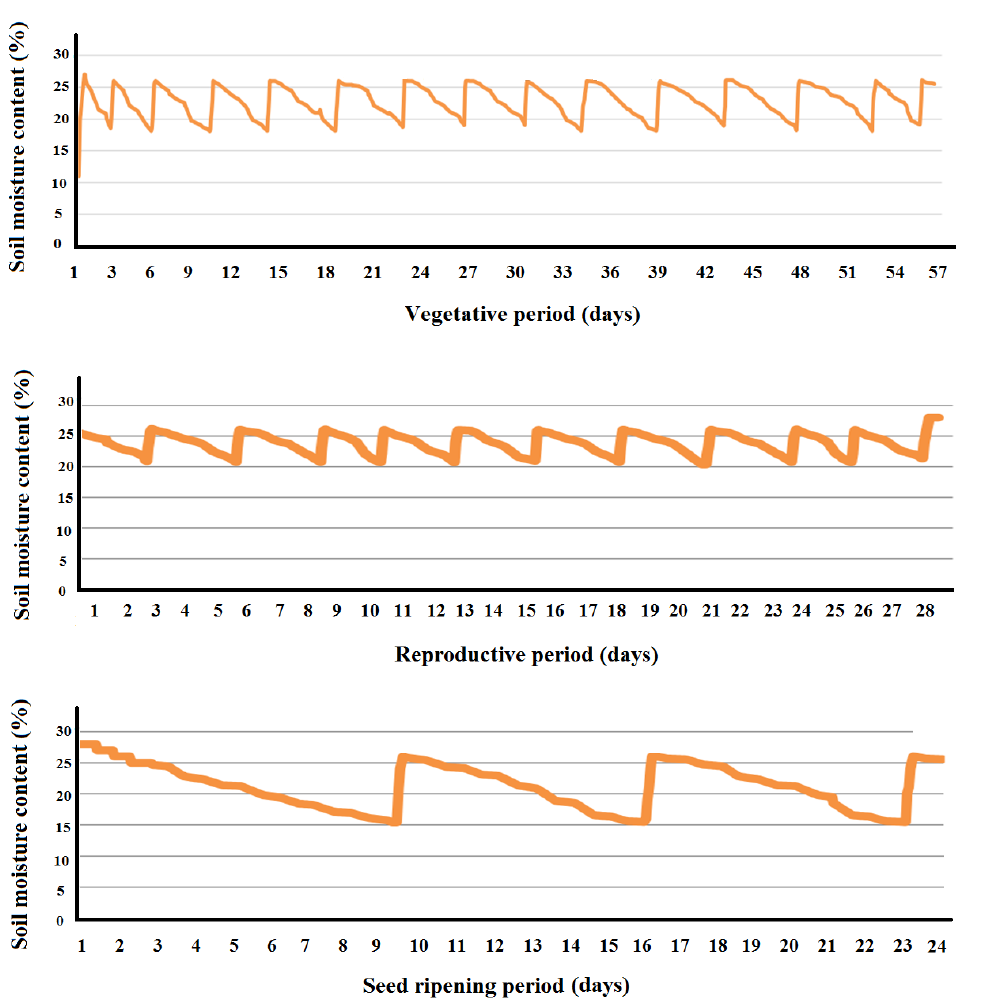
Figure 3. Moisture percentage at different times.